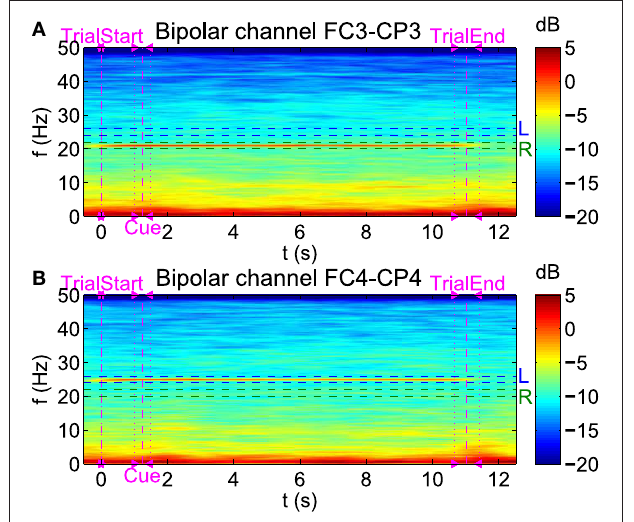
FIGURE 7 | Visualization of SSSEPs. Spectrograms (4096-point FFT, 3s window length, 2.95s window overlap) of subject s01 showing the PSD (in dB) during simultaneous left (25Hz) and right (21Hz) index finger stimulation can be seen for the bipolar channels (A) FC3-CP3 and (B) FC4-CP4.